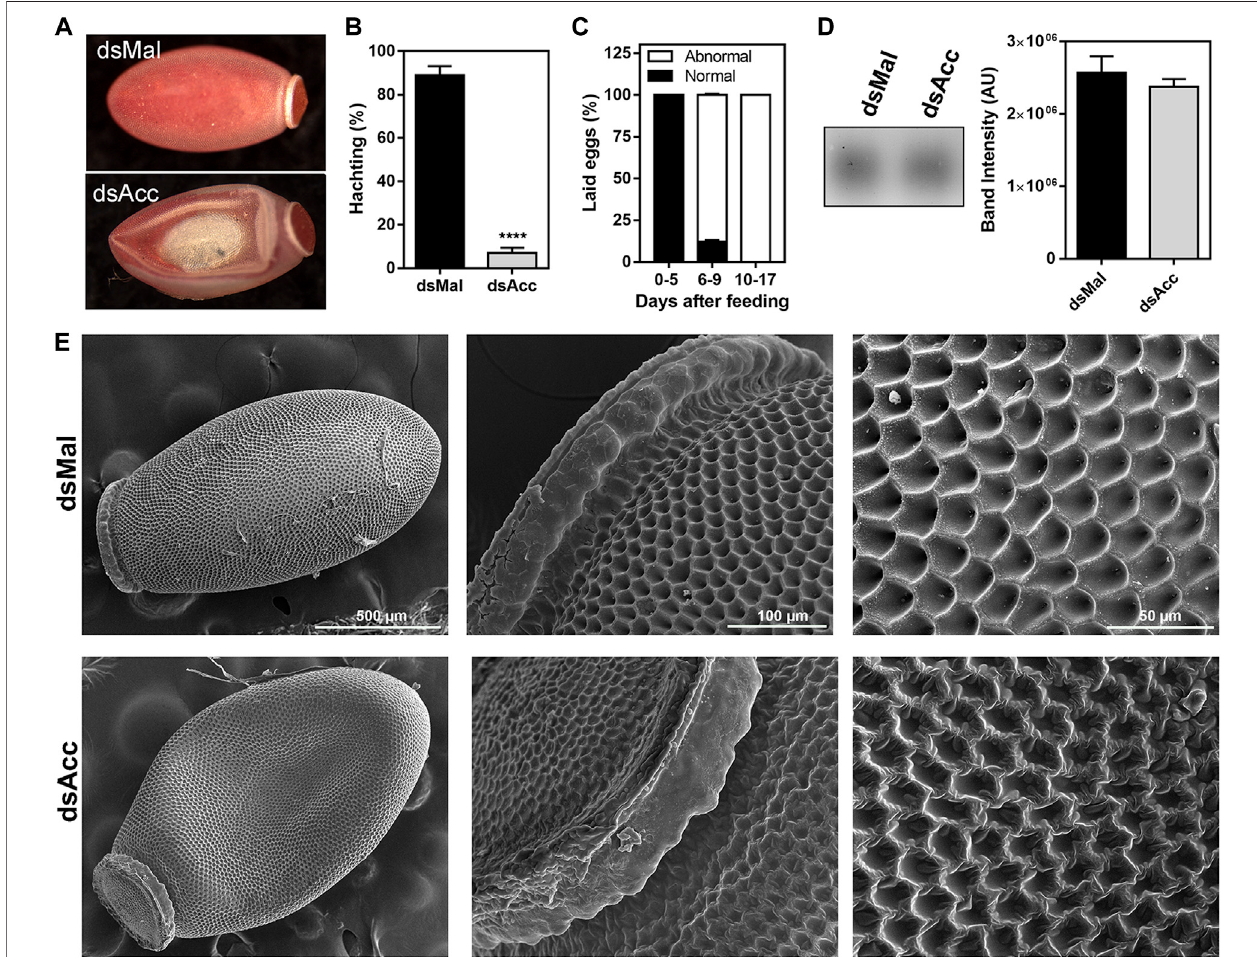
FIGURE 7 | Acc knockdown females deposited eggs with defective chorion structure. The starving adult females were injected with 1 µg of dsRNA for Acc or Mal (control)andwerefed3 dayslater. (A) Chorionatedeggs,depositedbydsMalanddsAccinjectedfemales.Eggswerecollectedondifferentdaysoftheovipositioncycle, and (B) thetotalnumberofhatchedeggsineachgroupwasdetermined.(****): p < 0.0001,by χ 2test,n=1687. (C) Frequencyofmorphologicalalterationsamongeggs laid by females injected with dsAcc (n = 167). (D) Hydrocarbons extracted from the eggshells of eggs laid by AccKD and control females were evaluated by TLC, followed by densitometry (n = 3). (E) The laid eggs were processed for scanning electron microscopy, and their surface ultrastructure was examined.